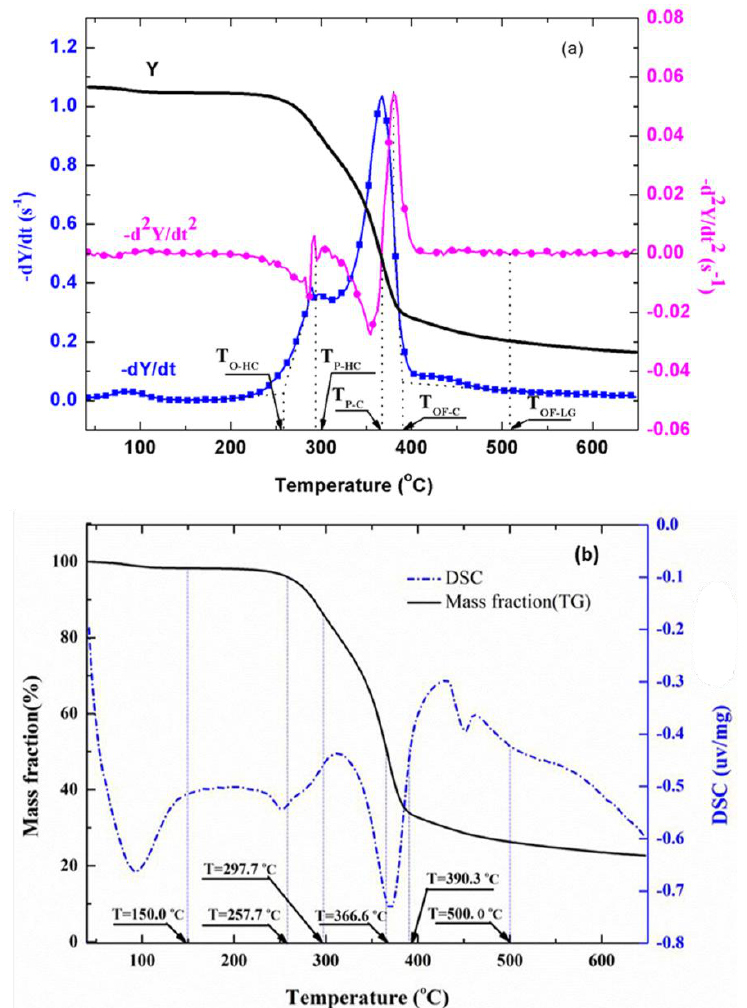
Figure 4. TGA and DSC data for untreated wood. ( a ) TG, DTG, and DDTG curves and definition of characteristic reaction temperatures; ( b ) combined TG and DSC curves and characteristic reaction temperature